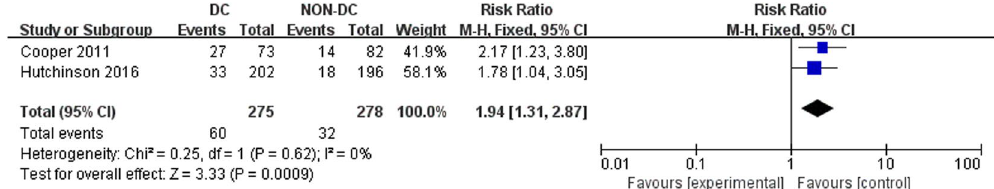
Figure 6. Forest plots for the effect of DC versus NON-DC on complications. DC, Decompressive